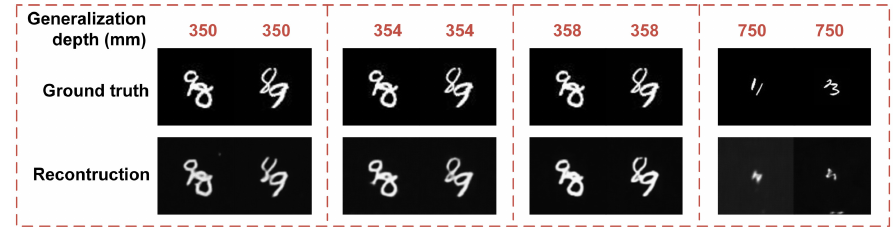
Figure 6. Reconstruction results in generalization